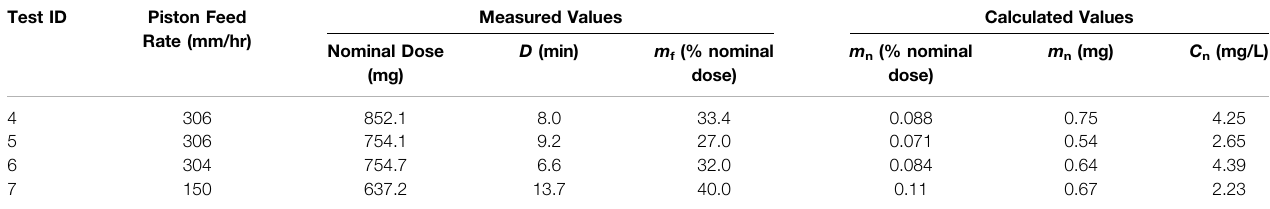
TABLE 6| SummaryofRBG-NOID characterizationexperimentswiththespray-driedC2formulation.TheC2formulationwasdesigned fordepositioninthenoseand lungs of mice upon inhalation. Abbreviations: RBG – rotating brush generator; NOID – nose only inhalation device. Test ID